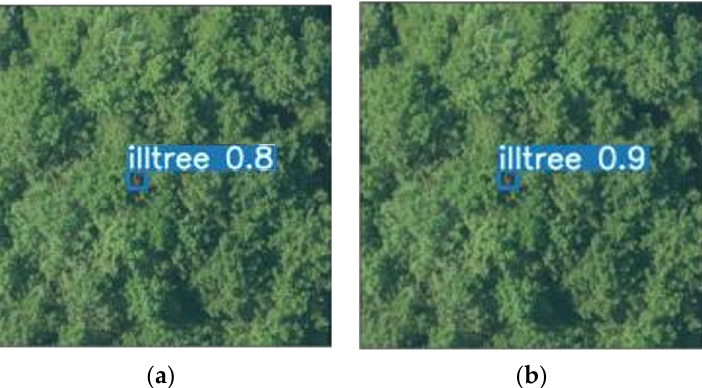
Figure 16. Algorithm comparison figure. ( a ) Algorithm detection results of YOLOv4; ( b ) Algorithm detection results of MobileNetv2-YOLOv4.